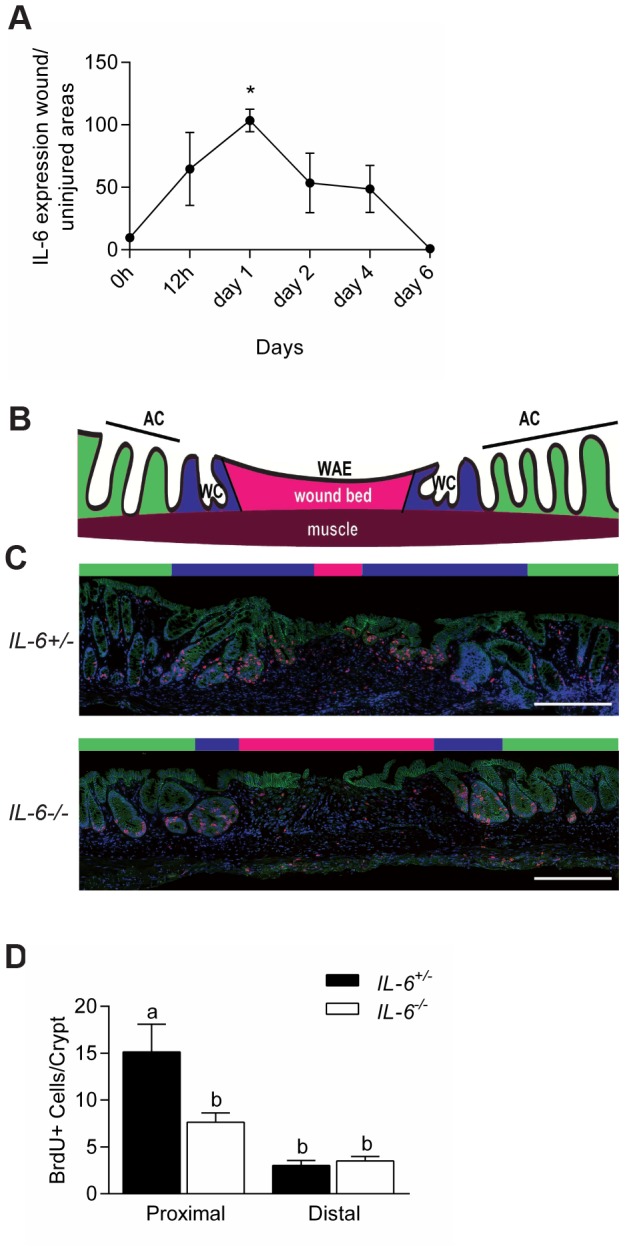
IL-6 promoted intestinal epithelial proliferation in wound biopsy model.(A) WT mice were biopsy injured in the distal colon. Plot of the relative levels of IL-6 mRNA expression in the wound bed (relative to uninjured tissue) for various times after injury. N = 2–3 WT mice with a total of 4-6 wounds/time point. Data were shown as average ± SEM. One-way analysis of variance: F = 5.68, P<0.01 (B) Cartoon depicting the microanatomy of a wound at day six post-biopsy; AC  =  adjacent crypts (green area); WC  =  wound channels (blue area); WAE  =  wound-associated epithelium overlying the wound bed (pink area). (C) Colonic sections of wounds from IL-6+/− and IL-6-/- mice at day six post-injury stained with mAb to BrdU (labels S-phase cells, red), mAb to β-catenin (labels epithelium, green), and bis-benzimide (nuclei, blue). Bars = 500 µm. (D) Quantification of the number of BrdU positive cells/wound adjacent crypts. Data were graphed as average ± SEM. One way analysis of variance: F = 10.5, p<0.0001. Means with different letters are significantly different by Bonferroni's multiple comparison test.